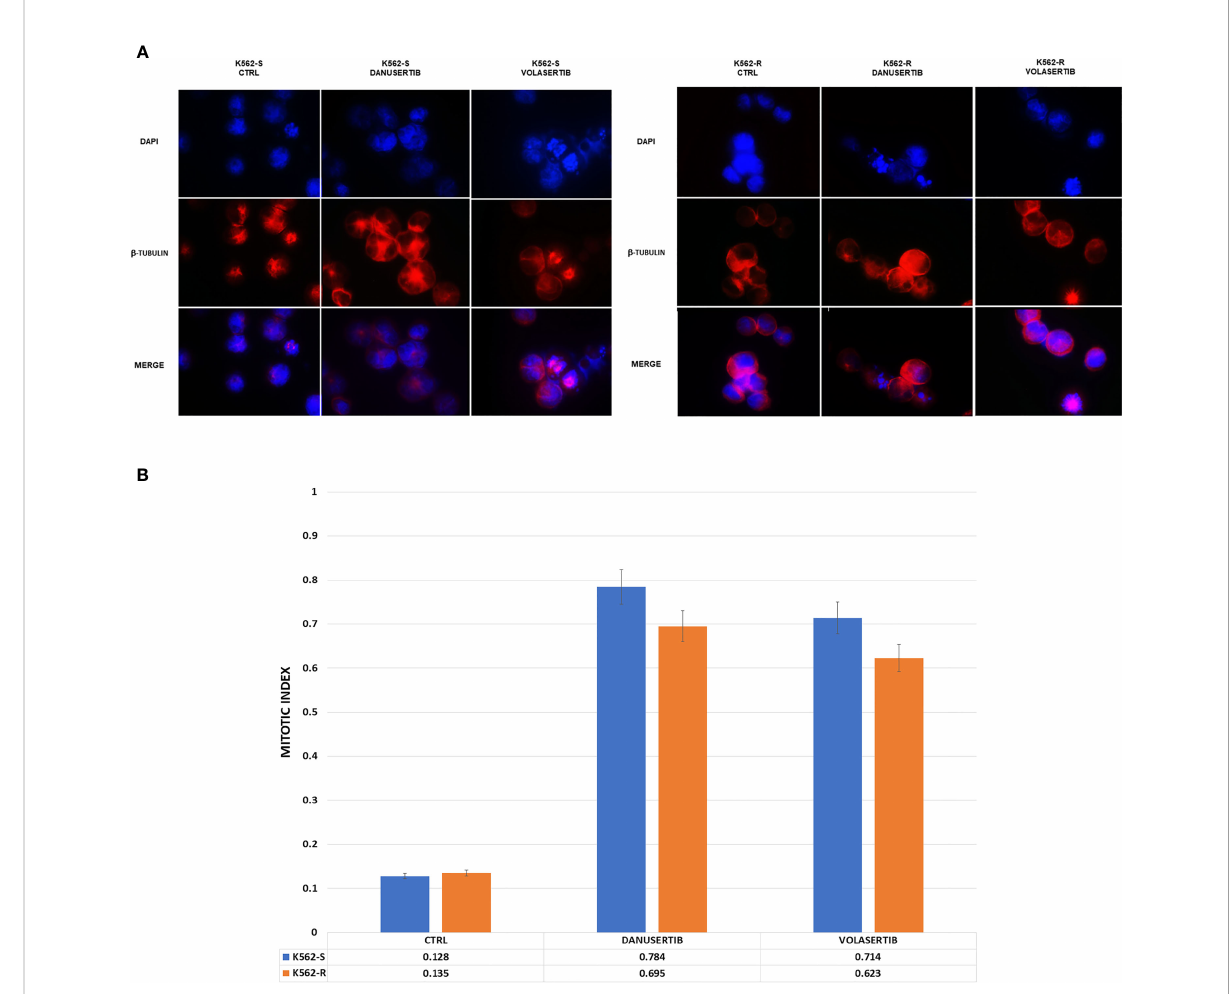
FIGURE 3 Effects of Aurora kinase A and PLK1 inhibition on cell division. (A) Immuno fl uorescence analysis of mitotic cells after staining with DAPI (4 ’ ,6- Diamidino-2-Phenylindole) and b -tubulin in K562S and K562R cells treated with 1 m M danusertib or volasertib for 24 hours. K562R cells were maintained under imatinib (10 m M) pharmacological pressure. The mitotic index was calculated as the ratio of the number of mitotic cells/ number of total cells. (B) A bar graph representing mitotic index values of K562S (light blue bars) and K562R (orange bars) cell lines. Results are the mean of three independent